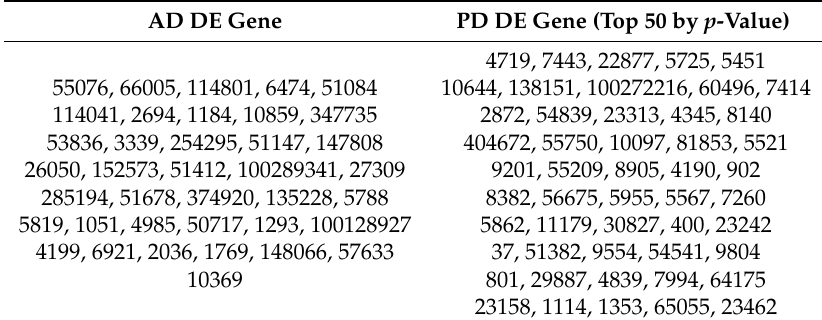
Table 7. Entrez ID of DE genes in AD and